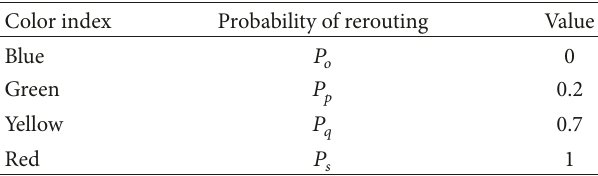
Table 5: Function expressions of the approach legs (with the coordinate origin in pixel moved to the upper left corner of the radar echo image).